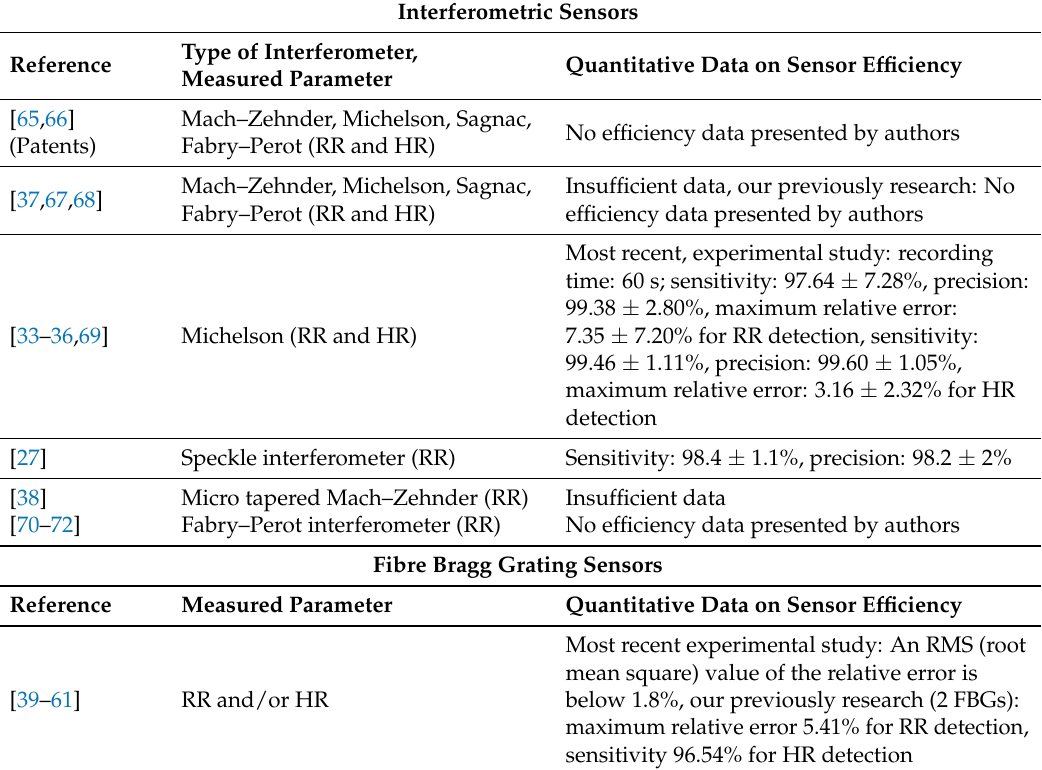
Table 2. A comparison of the most interesting fibre-optic sensors (based on the both interferometric and Bragg gratings designs) designed for monitoring respiratory rate and heart